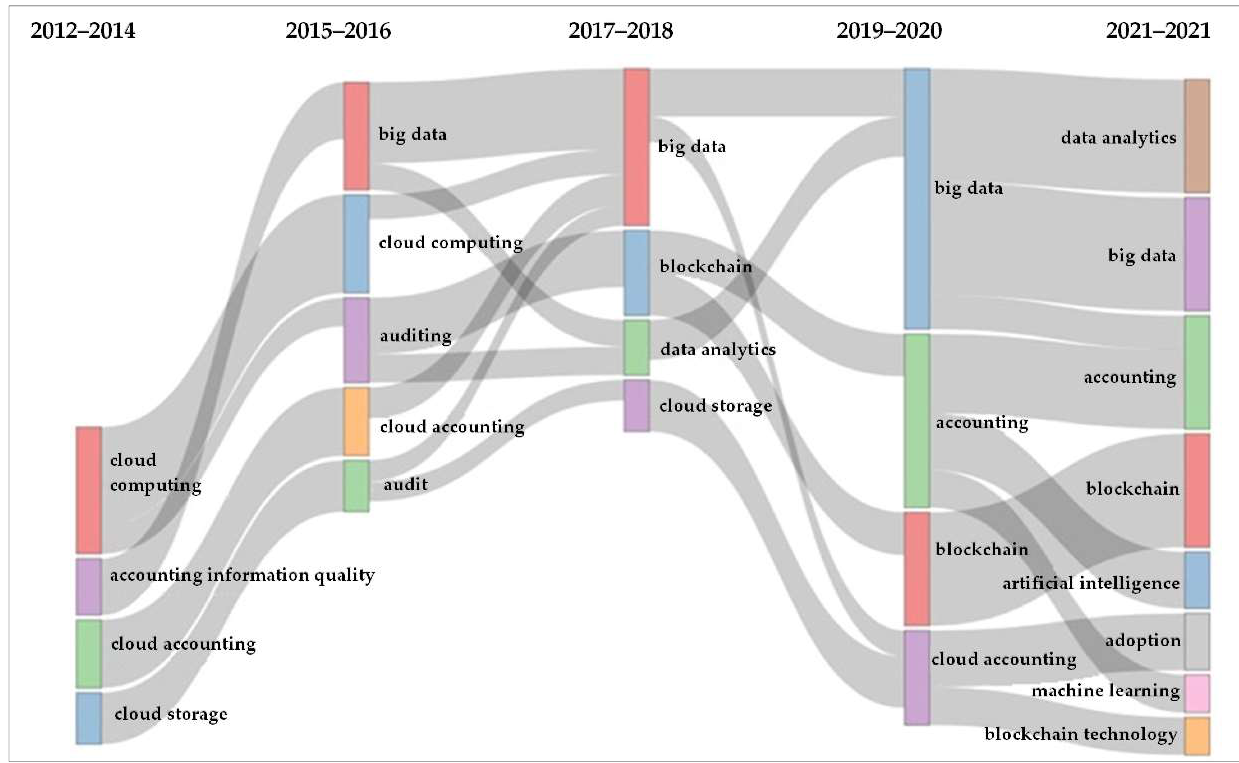
Figure 1. Topic evolution. (Source: author’s creation).